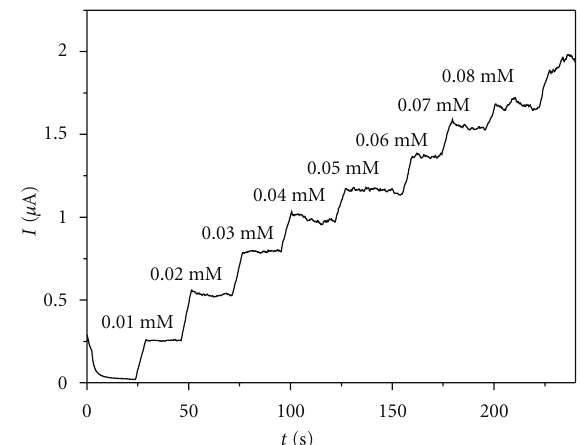
Figure 6: Continuous chronoamperogram at one potential level, +0.9V versus SCE, around the corresponding current peak poten- tial from CVs; progressive addition of ASA in the concentration range of 0.01mM–0.08mM; supporting electrolyte: 0.1M Na 2 SO 4 pH 7; stirred